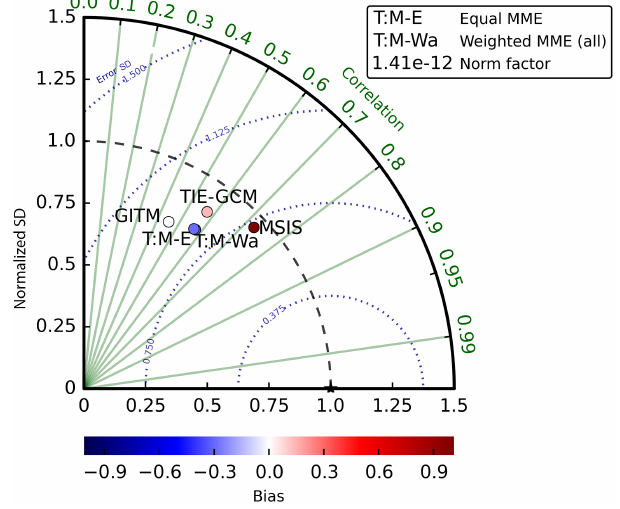
Figure 19. Modified Taylor diagram for NRLMSISE-00 (MSIS), TIE-GCM, GITM, and for TIE-GCM using the MMEs (equal and all-time weighted) for its initial conditions every 6h, compared with the CHAMP observations. N.B. The two markers for the MMEs overlap each other. Details of how to read the diagram are described in Fig. 2.